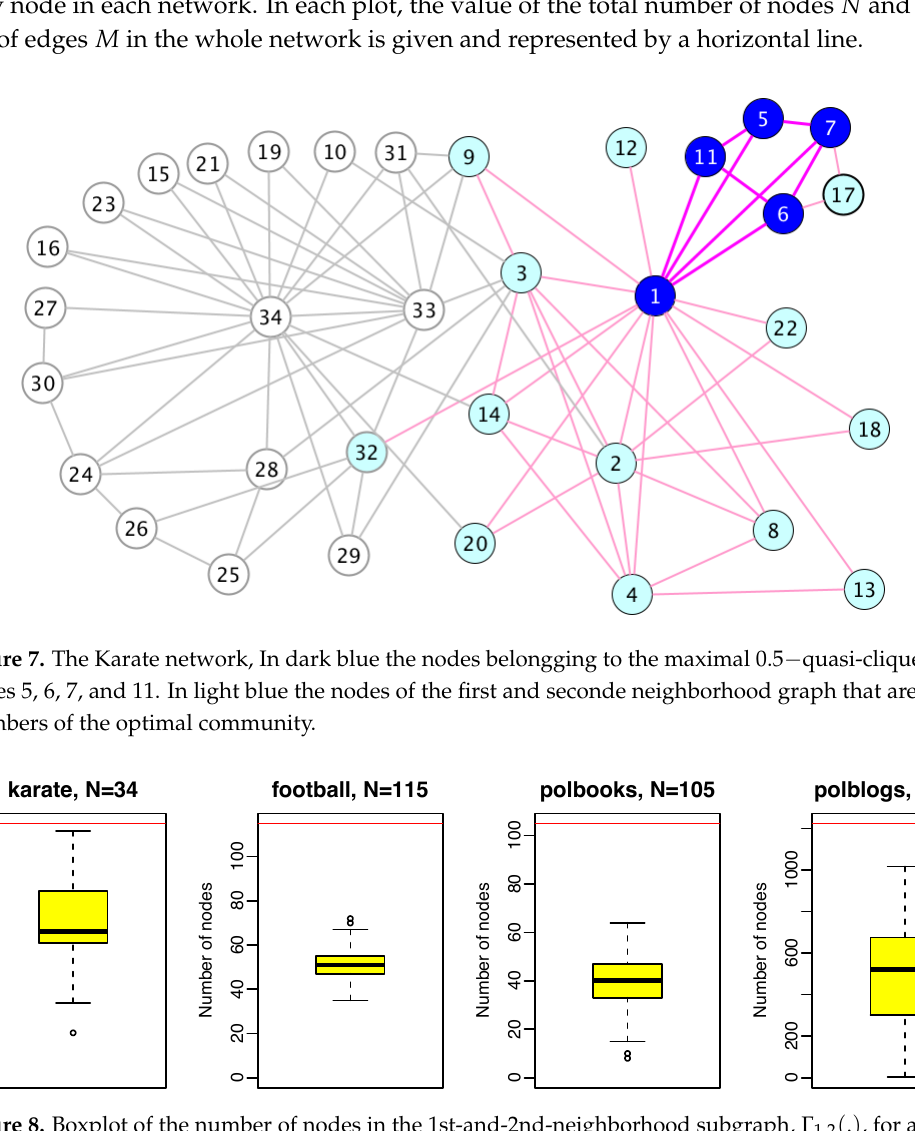
Figure 8. Boxplot of the number of nodes in the 1st-and-2nd-neighborhood subgraph, Γ 1,2 ( . ) , for all of the nodes in each network. The red line shows the total number of nodes in the whole network, N .